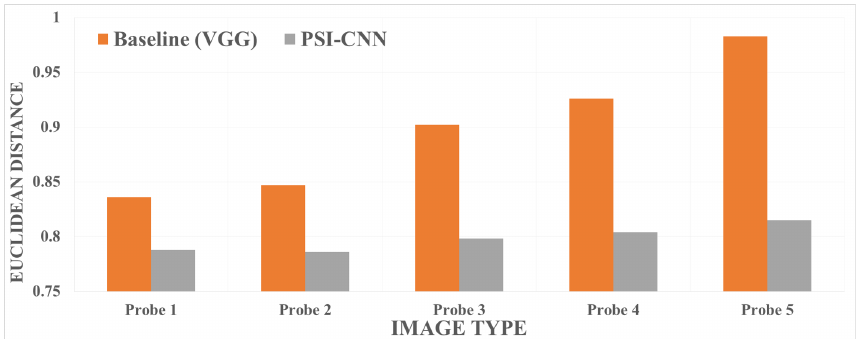
Figure 4. Some exemplary images in our CCTV dataset.